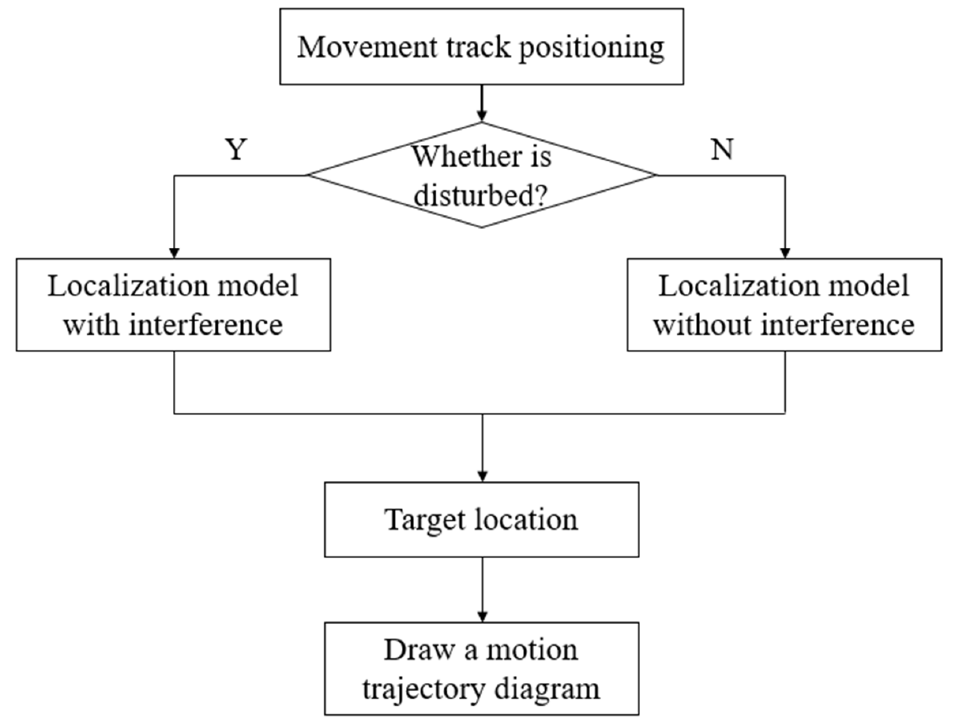
Figure 14. Movement track positioning technology route.